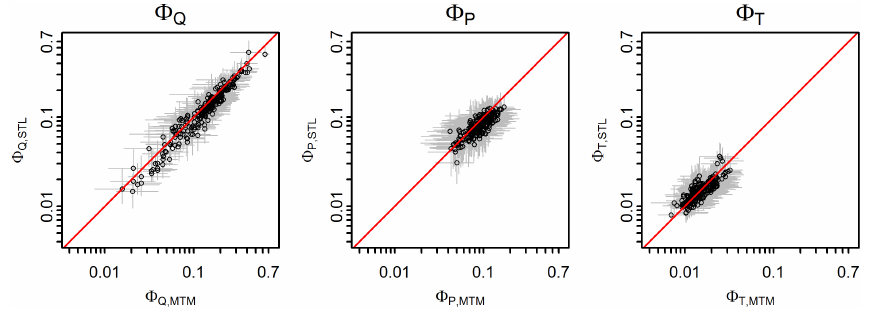
Fig. A1. Comparison of 8 X estimated with the STL algorithm ( 8 X, STL ) and the multi taper method ( 8 X, MTL ) for runoff ( 8 Q ), precipitation ( 8 T ) and temperature ( 8 T ). Grey bars are 95% bootstrap confidence intervals.